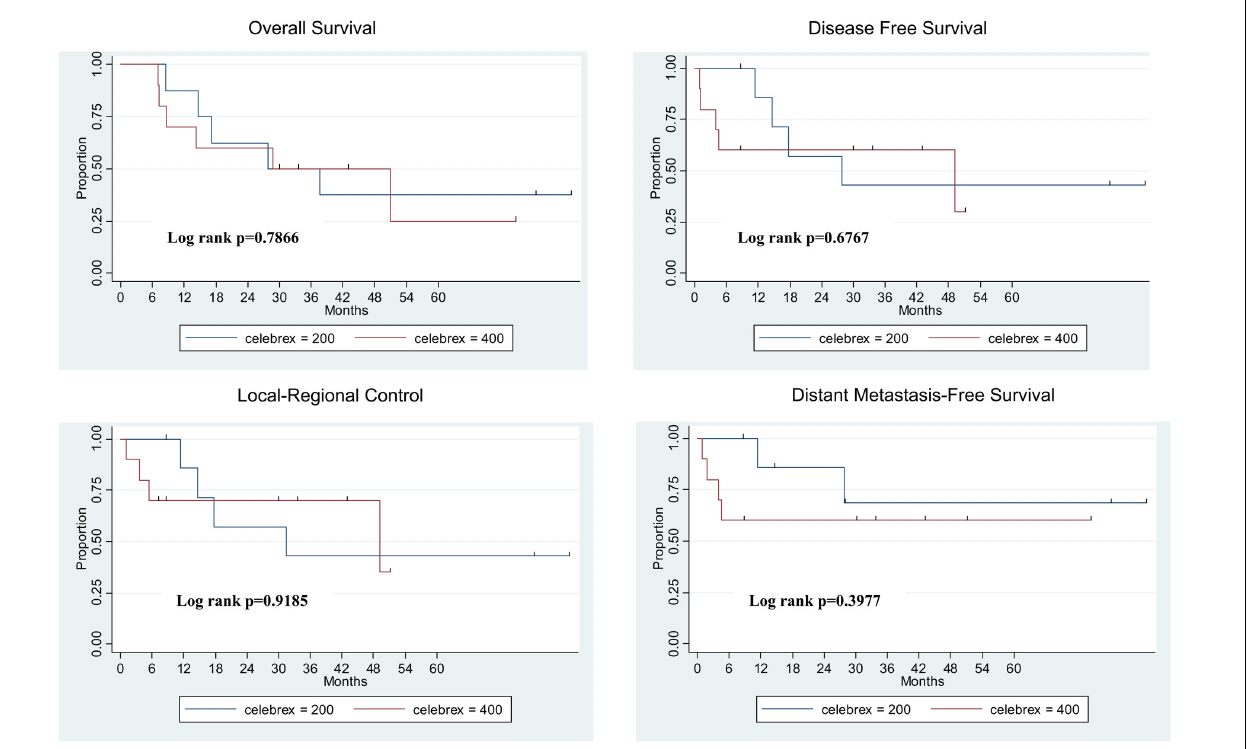
FIGURE 2 |Treatment outcomes for 18 eligible patients. Survival duration was measured from the day of registration to the date of last follow-up or documented death. Failure was measured from the day of registration to the date of first documented failure event.